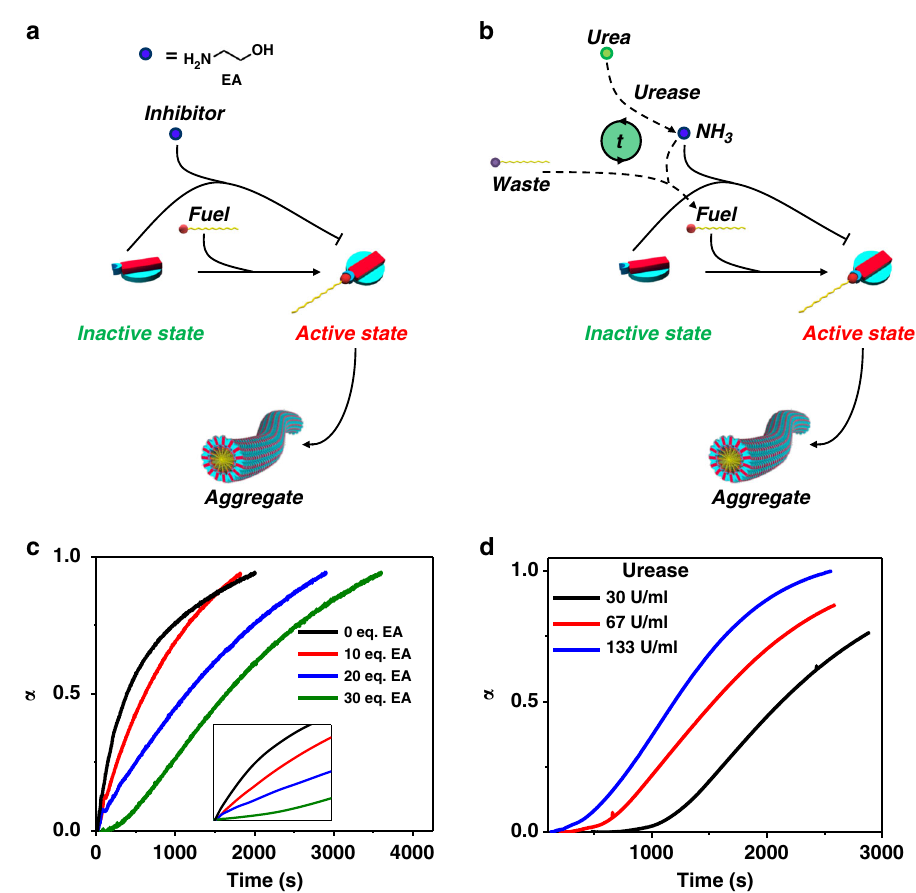
Fig. 4 Temporal control over nucleation. a Schematic representation of delay in growth through ligand dilution and delayed activation. Ligand dilution represents ethanol amine ( EA ) acting as a competitive inhibitor. b Schematic representation of delay in growth through delayed pH change using urease. c Absorbance trend, at 515 nm, of 1.2-8A growth with various equivalents of EA (inset: same graph on linear scale to easily elucidate the change in lag phase). ([ 1 ] = [ 2 ] = [ 8A ] = 1 mM, 50 mM pH = 11 buffer). d Absorbance trend, at 515 nm, of 1.2-8A growth with variation of urease